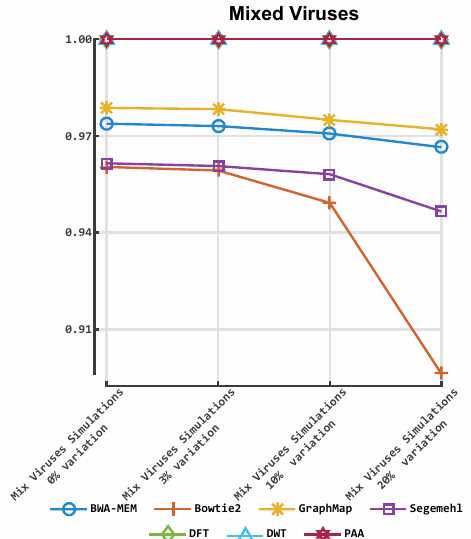
Figure 8. Accuracy of our prototype aligner implementation and four established tools on mixed viruses simulated datasets. The y -axis indicates the F -measure score, and the x -axis depicts the reads data files. The plot depicts the F -measures obtained for each aligner on the mixed virus simulations. DFT: discrete Fourier transform; DWT: discrete wavelet transform; PAA: piece-wise aggregate